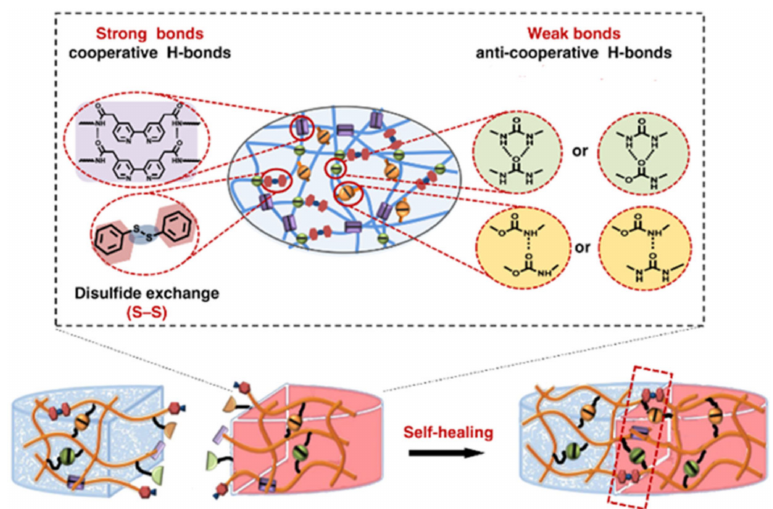
Figure 41. The proposed ideal SHP structure based on strong crosslinking H-bonds, weak crosslinking H-bonds and disulfide metathesis. Reprinted from